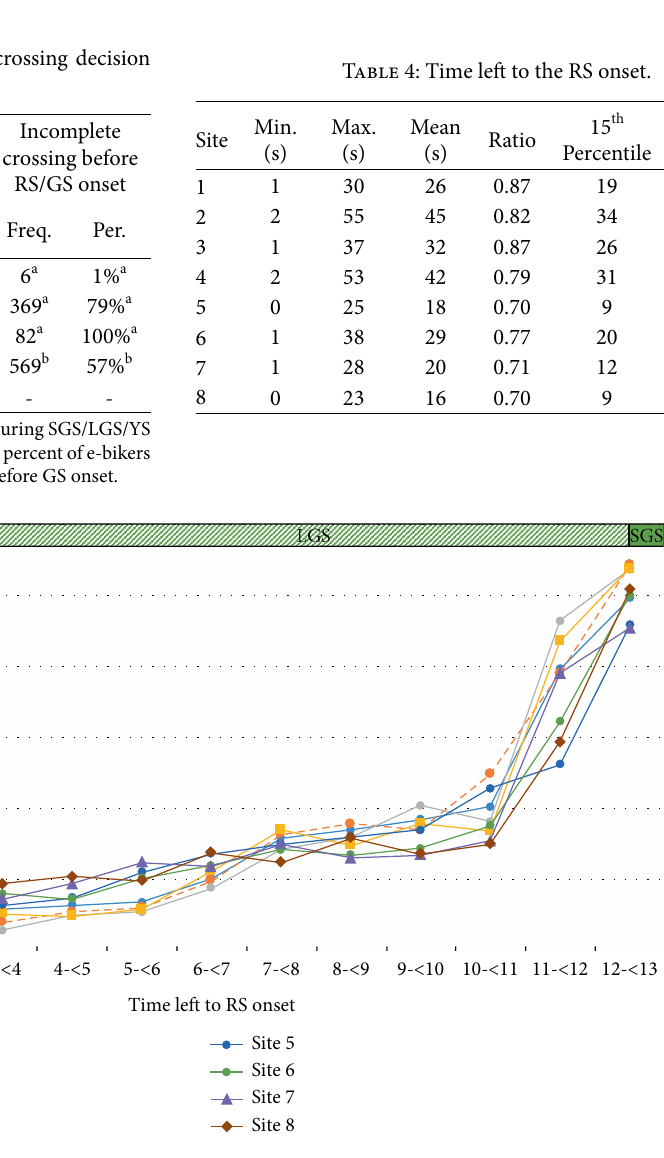
Figure 4: Ratio of crossing events during the time left to the RS onset (LGS and YS phases) in each